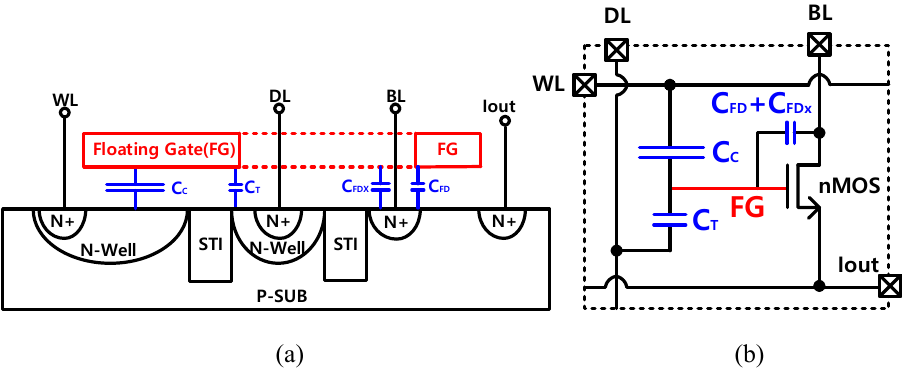
Figure 4. ( a ) Cross-section view and ( b ) equivalent circuit schematic for a single poly FG FET cell for a neuromorphic cross-bar array. Table 3. Comparison of stacked and planar EEPROMs.